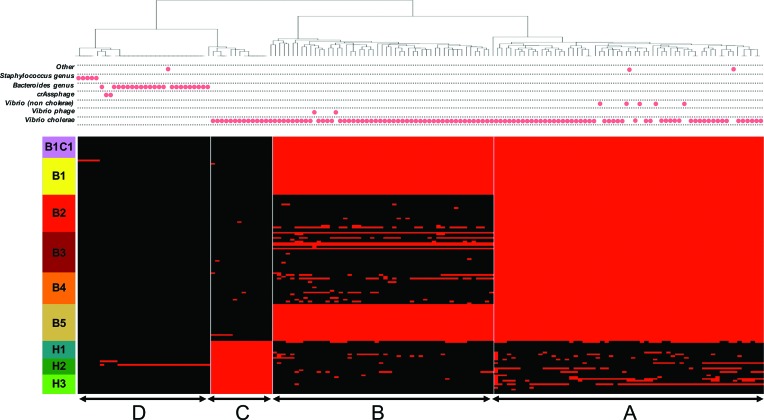
Presence/absence profile and taxonomic affiliation of gene families in the flexible genome. Red in the heatmap indicates gene presence; black indicates absence. Each column shows the presence/absence profile for a unique gene family. The heatmap is ordered by patient along the vertical axis. B1C1 is the control, subcultured from patient B1, and contains no flexible genome variation. The horizontal axis is ordered by hierarchical clustering, yielding four clusters: A, B, C and D. The taxonomic affiliation of each gene family (best blast hit) is indicated with dots above the heatmap.